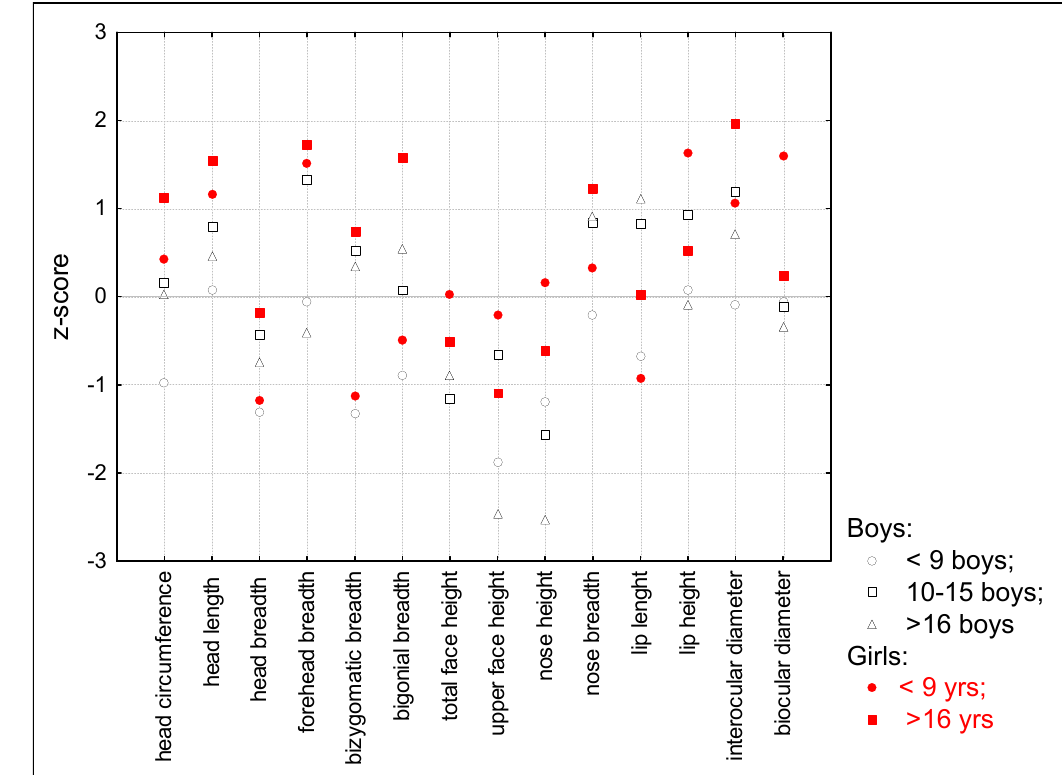
Figure 4. Craniofacial pattern profile in three age groups.